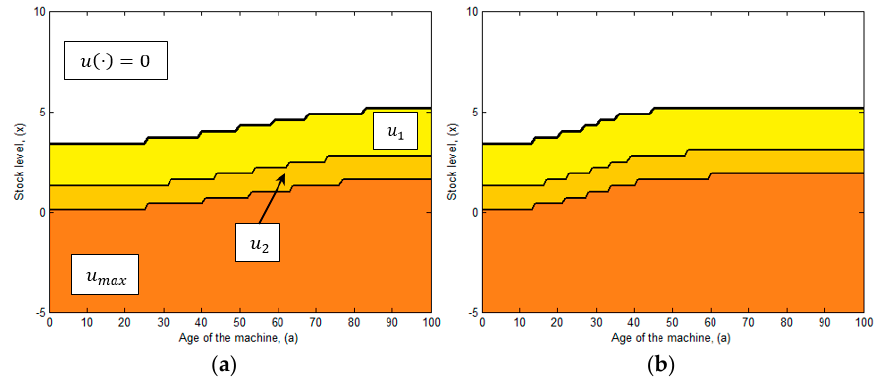
Figure 14. Sensitivity of the pace of the failure rate on the production policy. ( a ) θ = 0.15; ( b ) θ = 1.